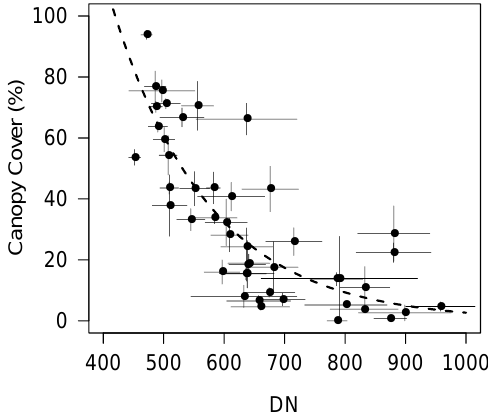
Figure 4. Inverse non-linear relationship between stand-level canopy cover and digital number (DN) from a March 2015 panchromatic WorldView2 image. Note the model was fit using standardized digital numbers (DN S ) and data were back-transformed for plotting. Vertical whiskers indicate standard error (SE) of mean canopy cover, and horizontal whiskers are one standard deviation (SD) of mean stand DN. We observed differences in tree and shrub phenology across the study area, as shown in Table